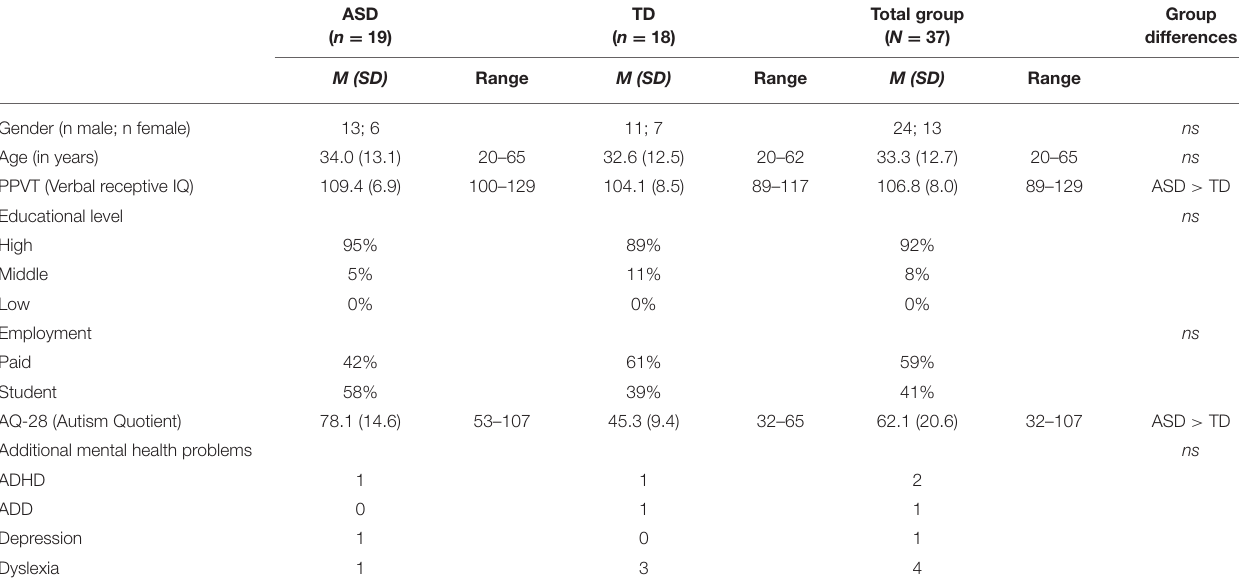
TABLE 1 | Descriptives for the ASD and TD groups.